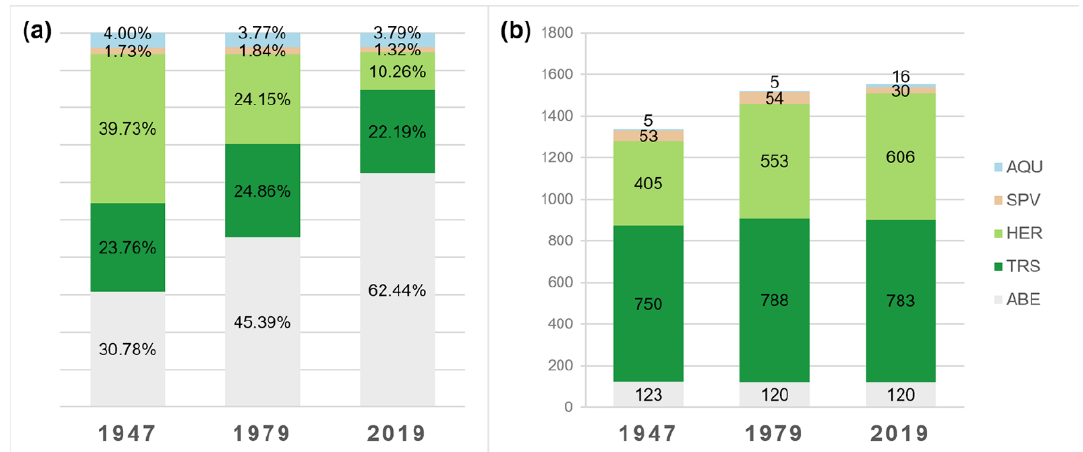
Figure 3. ( a ) Land cover class proportions in 1947, 1979, and 2019; ( b ) number of patches per class in 1947, 1979, and 2019 (see also Table A1).